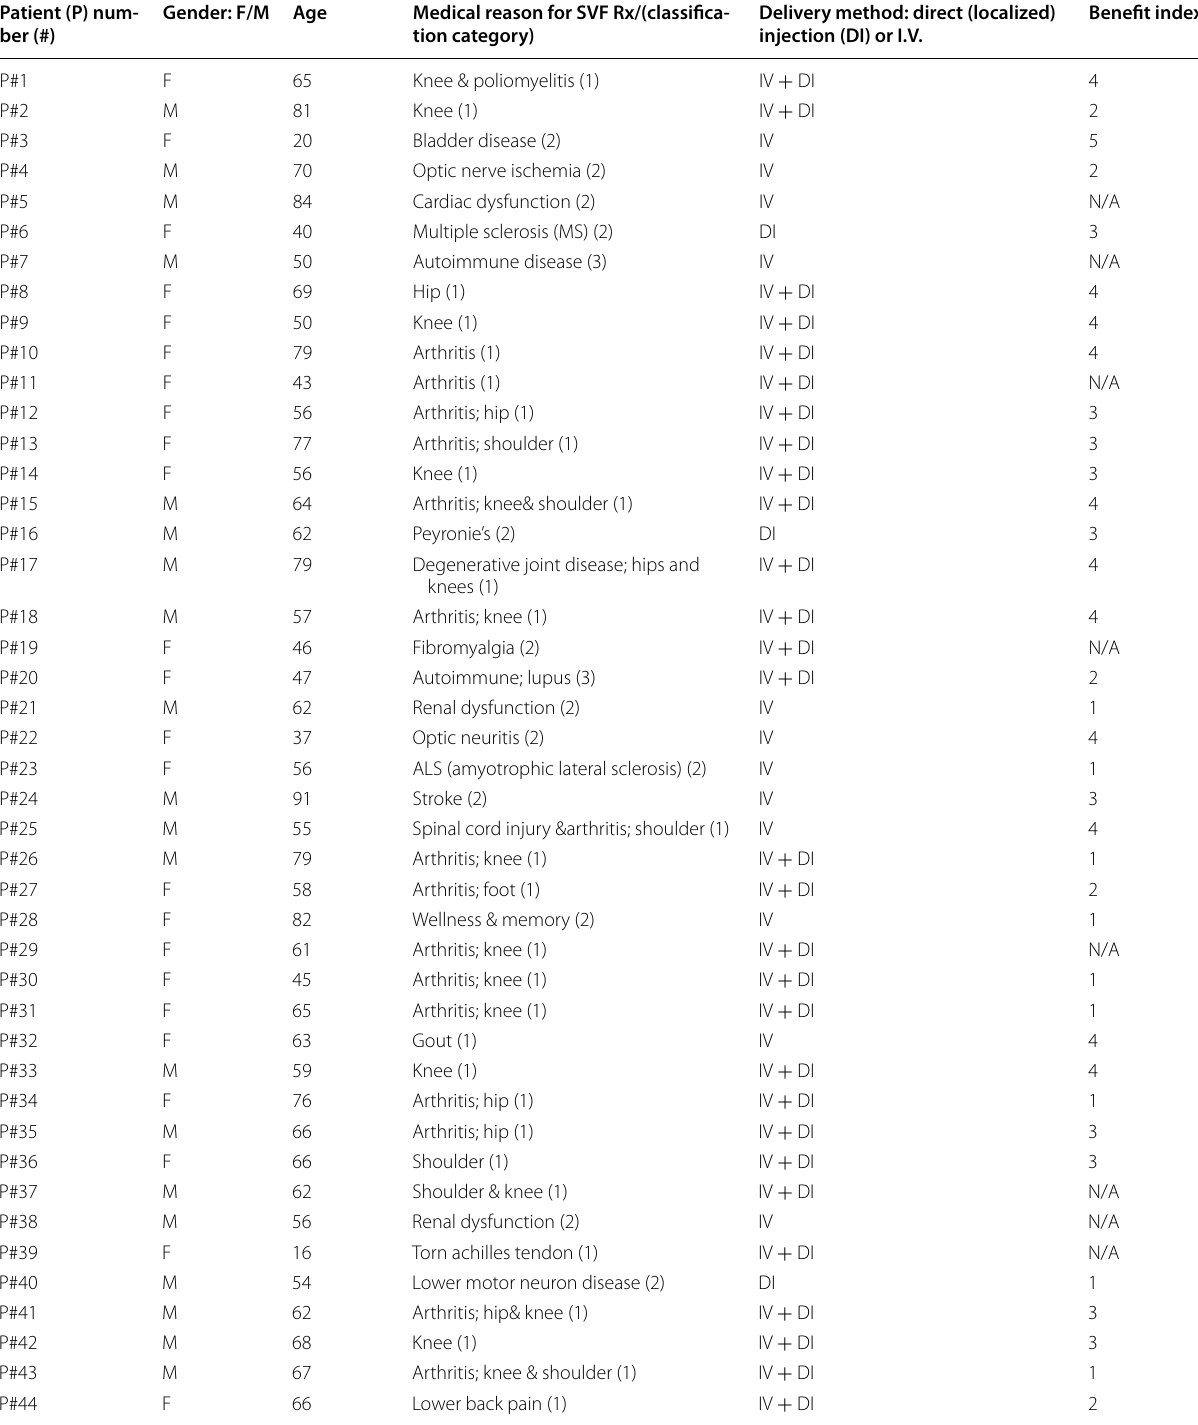
Table 1 List of 44 SVF-treated patient’s gender, age, medical reason, delivery methods and benefit index Patient (P) num‑ ber